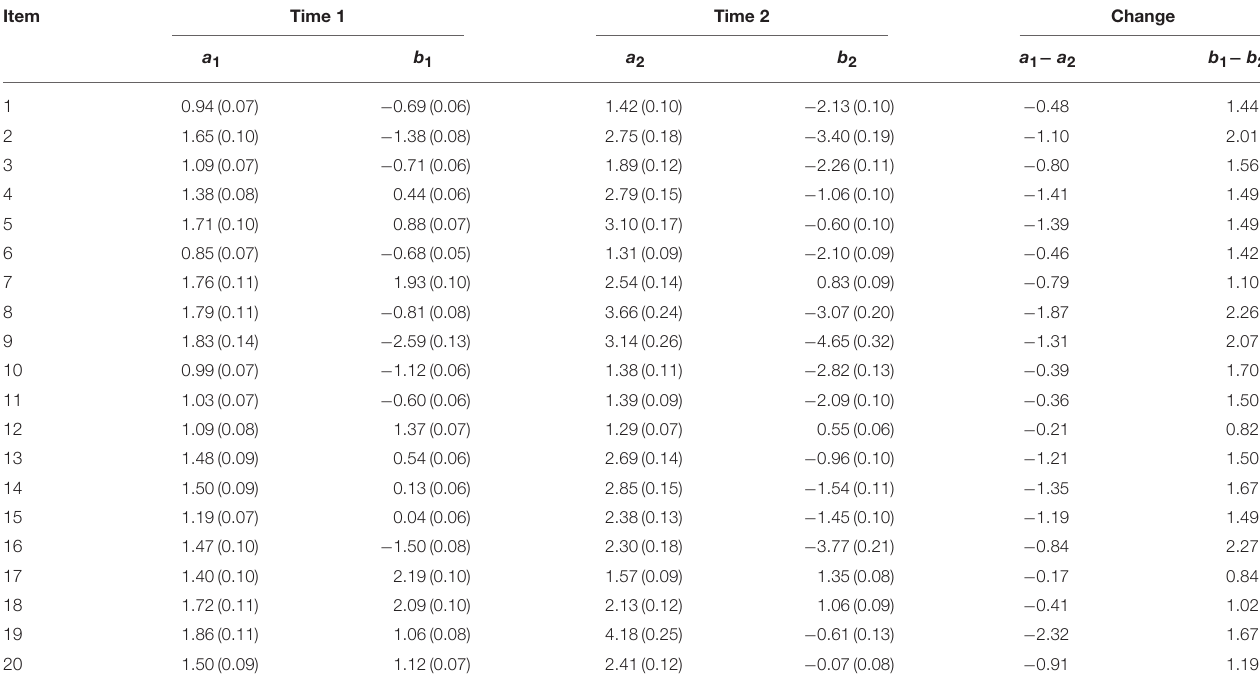
TABLE 10 | Fitting data generated from mixture IRT to unidimensional 2PL IRT model: Condition 5 [increase in item discrimination and change in ability distribution for group 1 at Time 2 to θ ∼ N (1,0.5)].